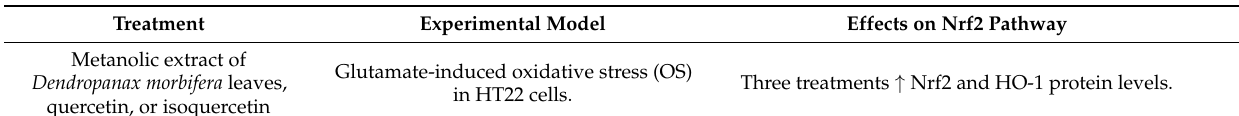
Table 1. Modulation of phenolic compounds on Nrf2 pathway in in vitro models. The increase in protein or RNAm levels are represented with ( ↑) and decrease is represented with ( ↓).